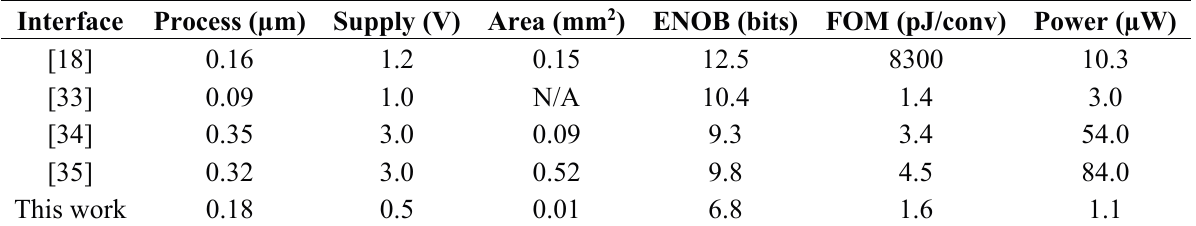
Table 2. Performance comparison of capacitive sensor interfaces.